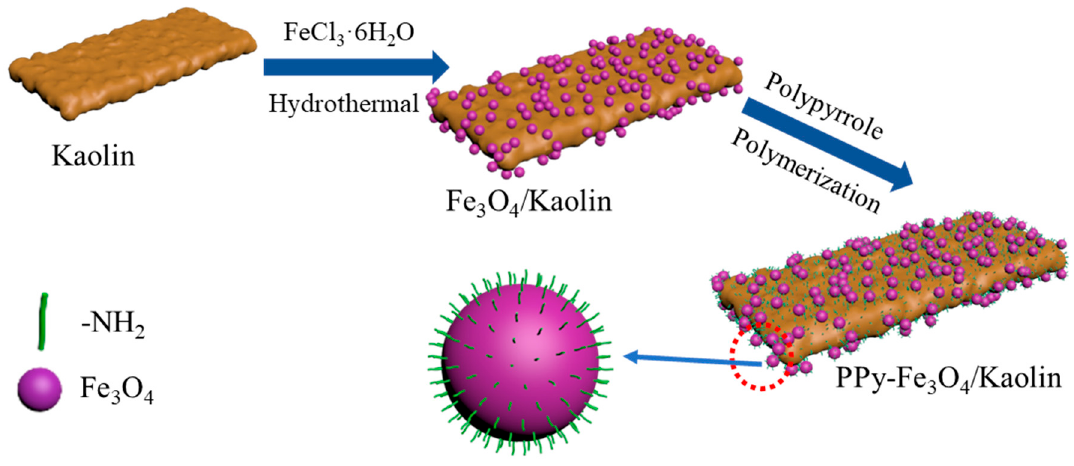
Figure 1. Prepared process of PPy-Fe 3 O 4 /Kaolin.